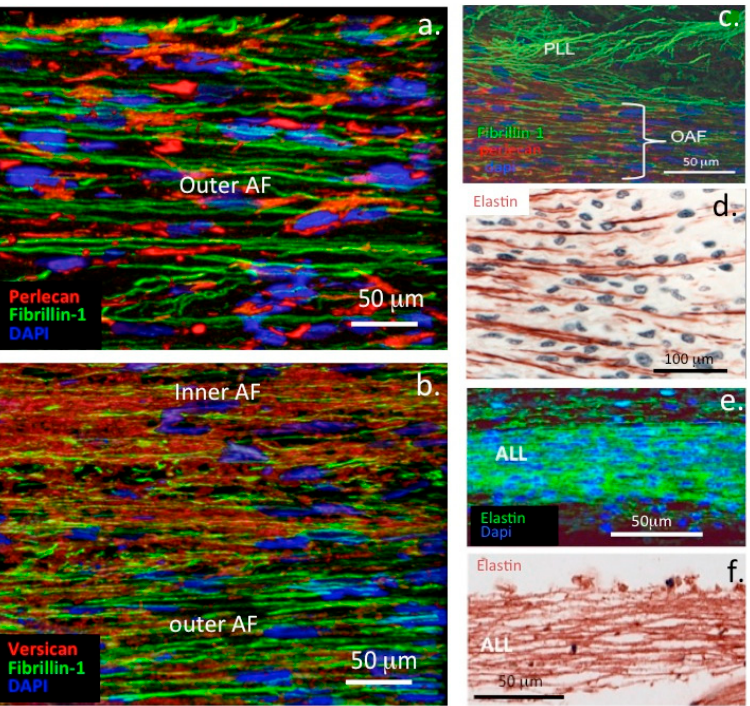
Figure 7. Perlecan interacts with fibrillin-1 and versican in the annulus fibrosus. ( a – c ) Confocal immunofluorescence localisations of perlecan (red in a , c ), fibrillin-1 (green) and versican (red in b ) in the annulus fibrosus of the human foetal intervertebral disc ( a , b ) and posterior longitudinal ligament (PLL; cc). ( d ) Immunoperoxidase image shows that elastin fibres act as anchorage points for the attachment of annular lamellae to cartilaginous endplates ( e , f ) Elastin immunolocalisation within the anterior longitudinal ligament (ALL) shown by confocal ( e ) and brightfield microscopy ( f ) Cell nuclei depicted in blue. Figures modified from [51–54] with permission.